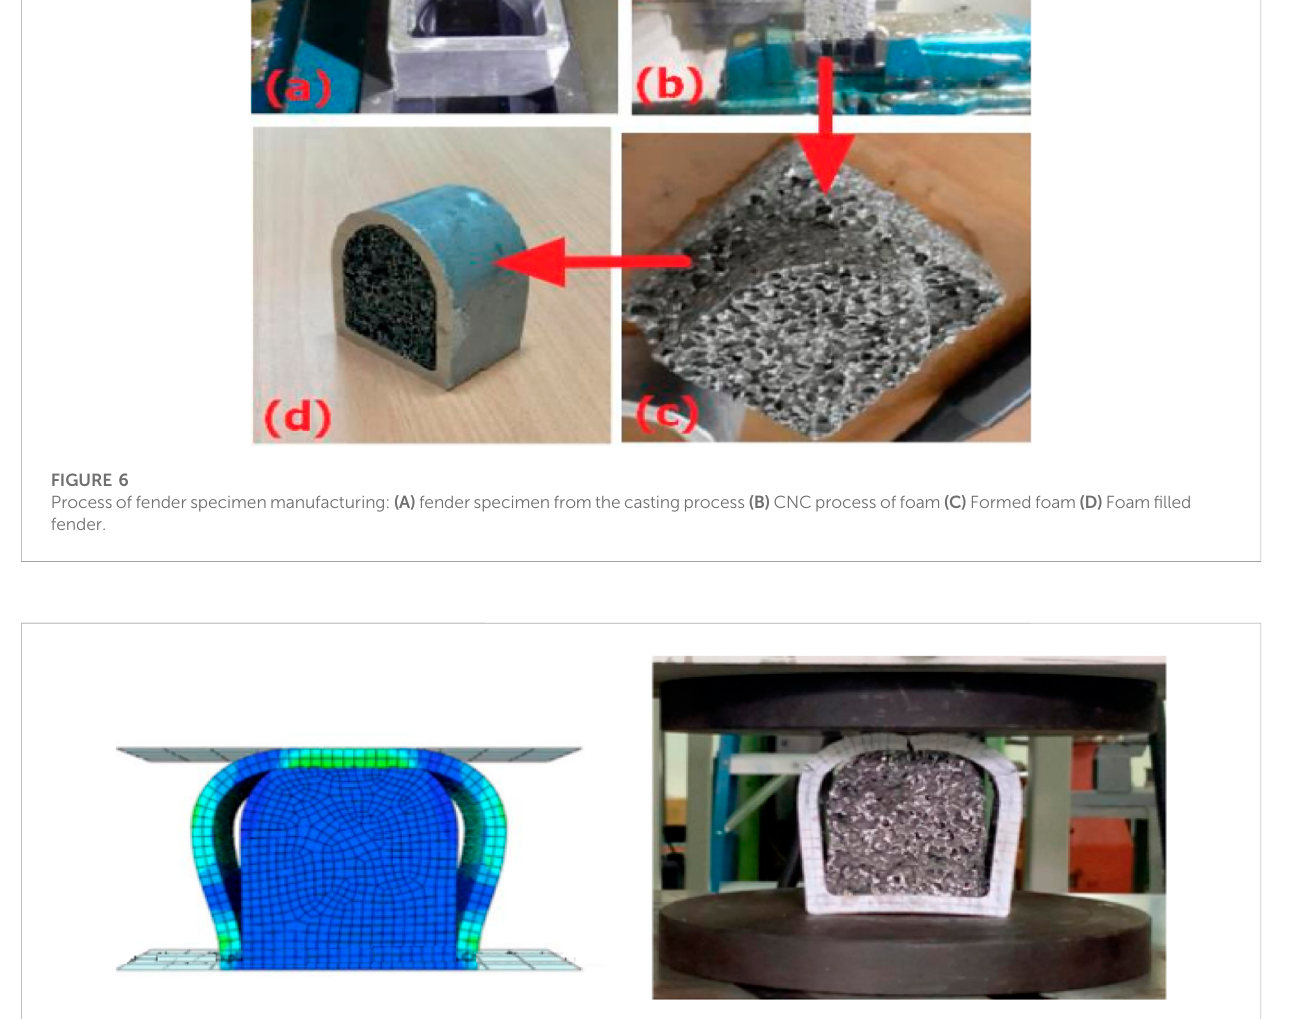
FIGURE 7 Simulation and experiment results.